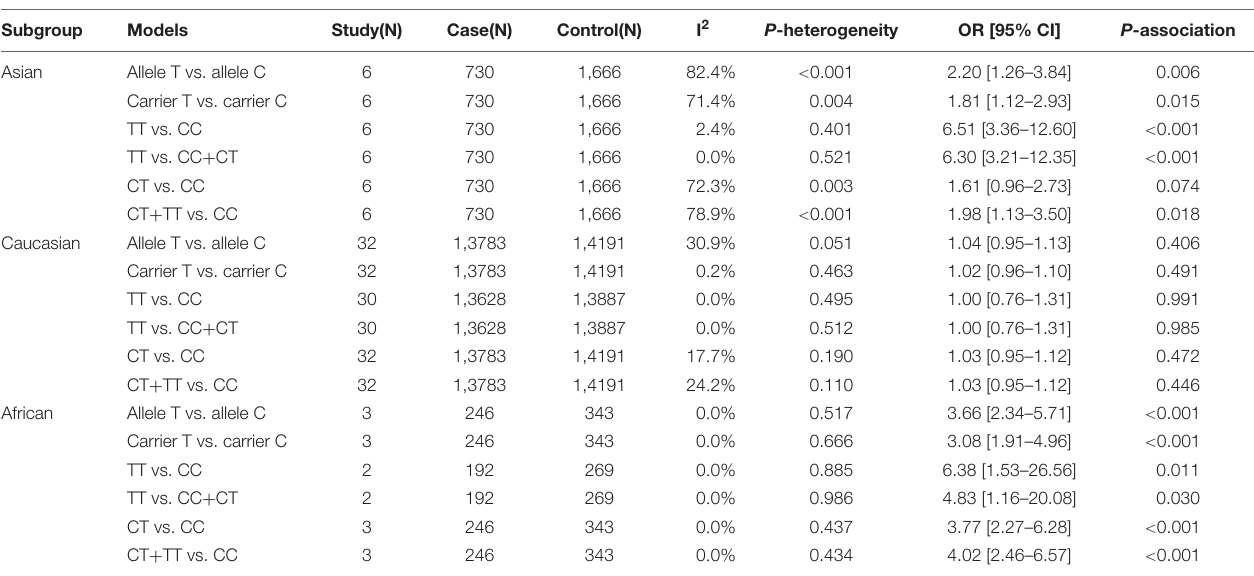
TABLE 3 | Subgroup analysis by ethnicity in the overall